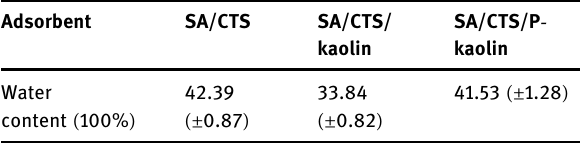
Figure 3: XRD images of SA/CTS/P - kaolin and kaolin.